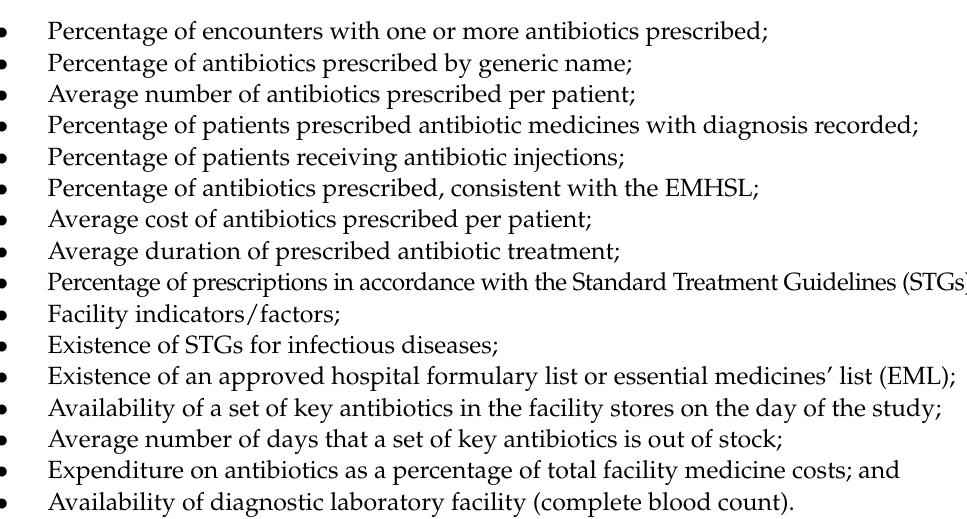
Table S5: Average cost of antibiotics prescribed per patient. Table S6: Average duration of prescribed antibiotic treatment. Table S7: Availability of a set of key antibiotics in the facility stores on the day of the study. Table S8: Average number of days that a set of key antibiotics is out of